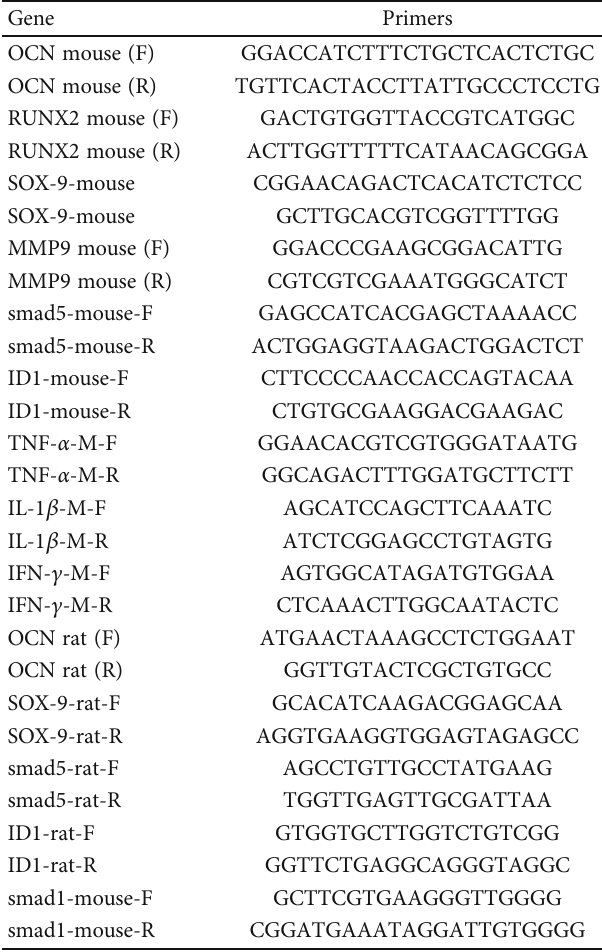
Table 1: The primer sequences used in this